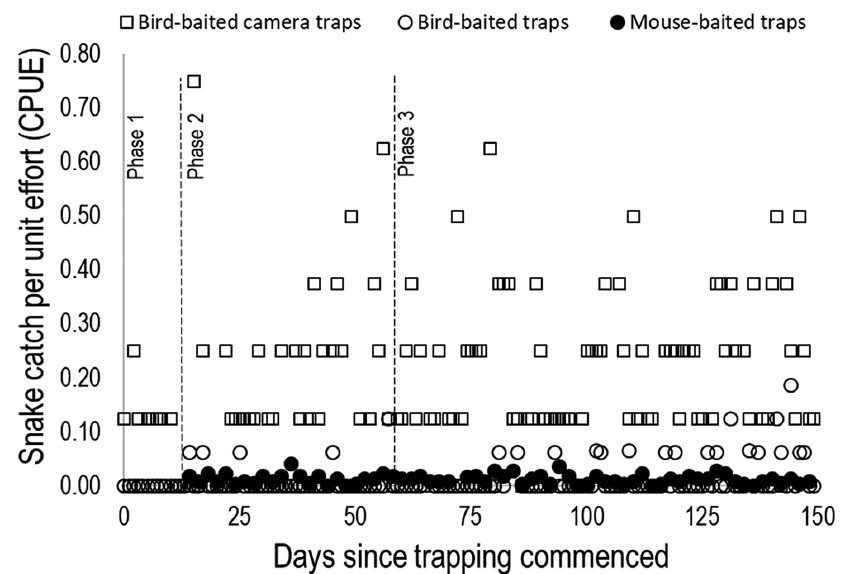
Figure 2. Brown treesnake catch per unit effort (CPUE) per trap night for bird-lure camera traps and bird- and mouse-lure live traps from 08 May through 05 October 2014 on the Guam National Wildlife Refuge, Guam. Open squares represent capturing a photographic image of the snake. Open and closed circles rep- resent actual successful snake captures from traps. Phase I = only bird-lure traps deployed, Phase II = both bird- and mouse-lure traps deployed, and Phase III = both bird- and mouse-lure traps deployed with snake removal from mouse-lure traps only. Cameras were deployed on bird-lure traps during all three phases.